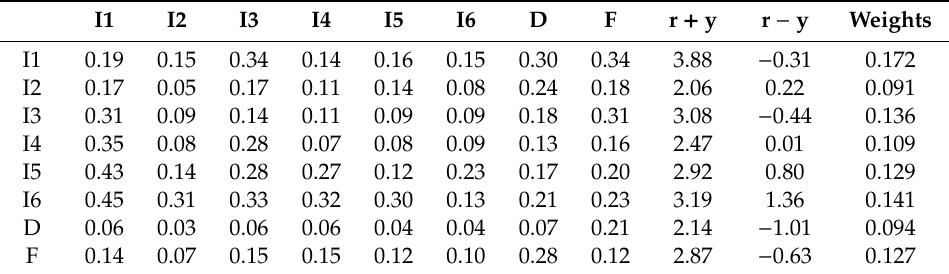
Table 3. Total relation matrix and impact-relation degrees of factors.